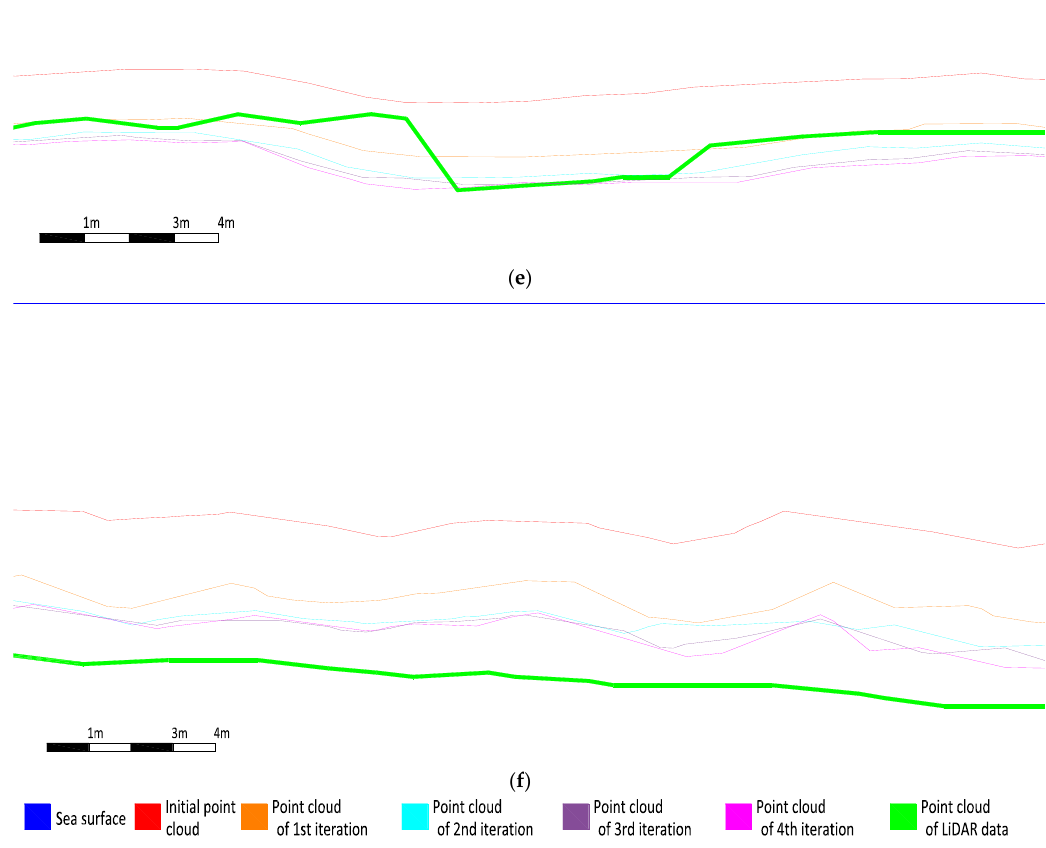
Figure 20. Parts of the cross sections having the same scale on X and Y axis. The blue line on the top of each cross section is the water surface while the bold green line is the section on the LiDAR data. ( a ) is the middle part of Section 1; ( b ) is the northern part of Section 2; ( c ) is the northern part of Section 3 ( d ) the middle part of Section 4; ( e ) is the middle part of Section 5 and ( f ) is the deepest part (south ‐ west) of Section 4.